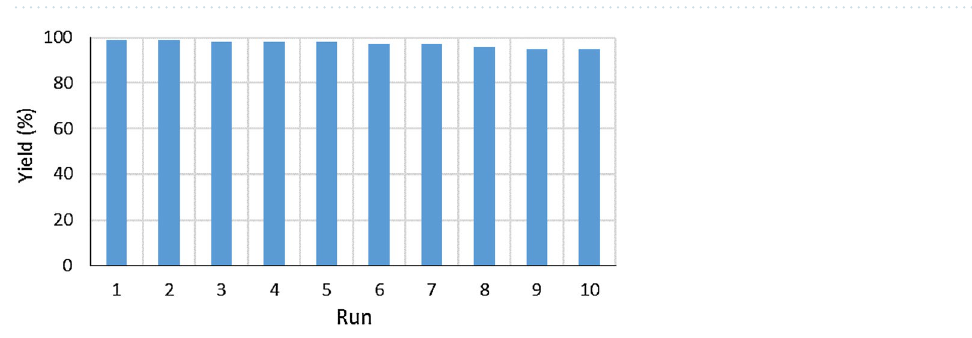
Figure 9. Reusability of γ-Fe 2 O 3 @MBD/Pd-Co in the reaction of n-butyl acrylate (1.3 mmol) with chlorobenzene (1 mmol) in the presence of γ-Fe 2 O 3 @MBD/Pd-Co (0.05 mol% based on the Pd content), base (2 mmol) in water (1 mL) in 4